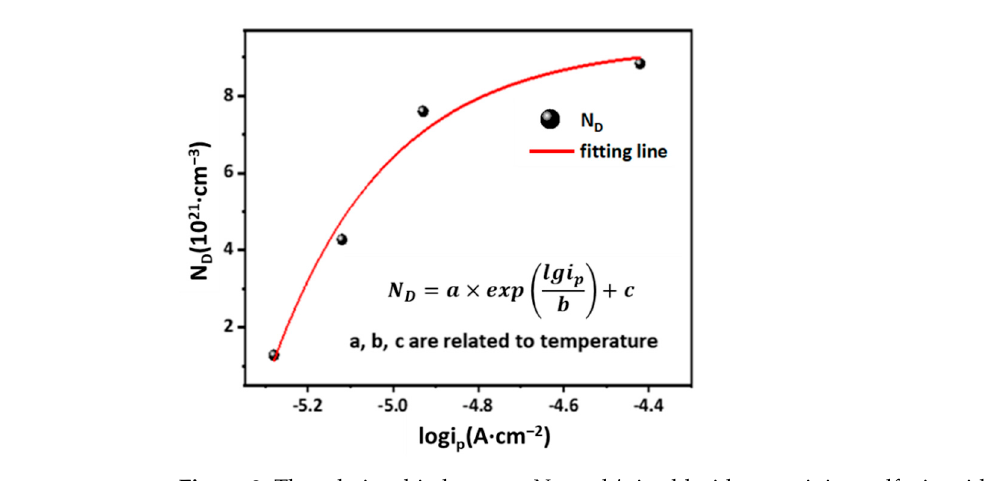
Figure 9. The relationship between N D and i p in chloride-containing sulfuric acid solution at different temperatures.